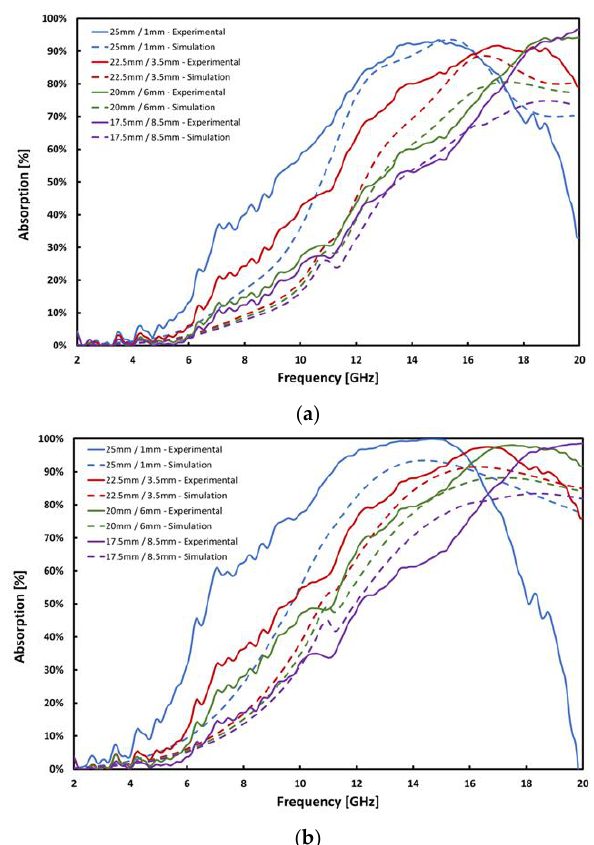
Figure 6. Comparison of model and experimental results of (a) 0.10% CNT/EA9396 and (b) 0.20% CNT/EA9396.